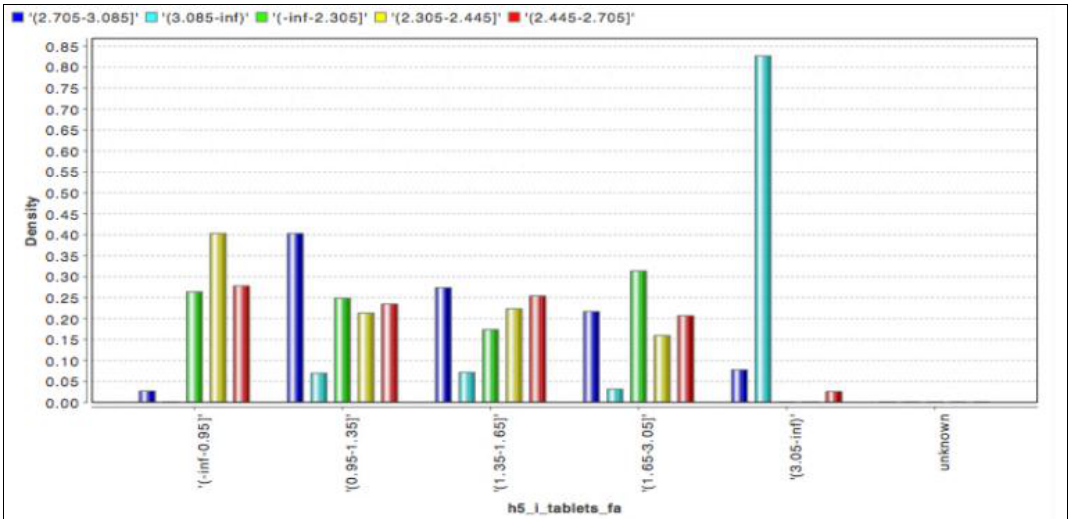
Figura 9. Densidad de probabilidad de intervalos discretos THDv en relación con la corriente del 5º armónico.